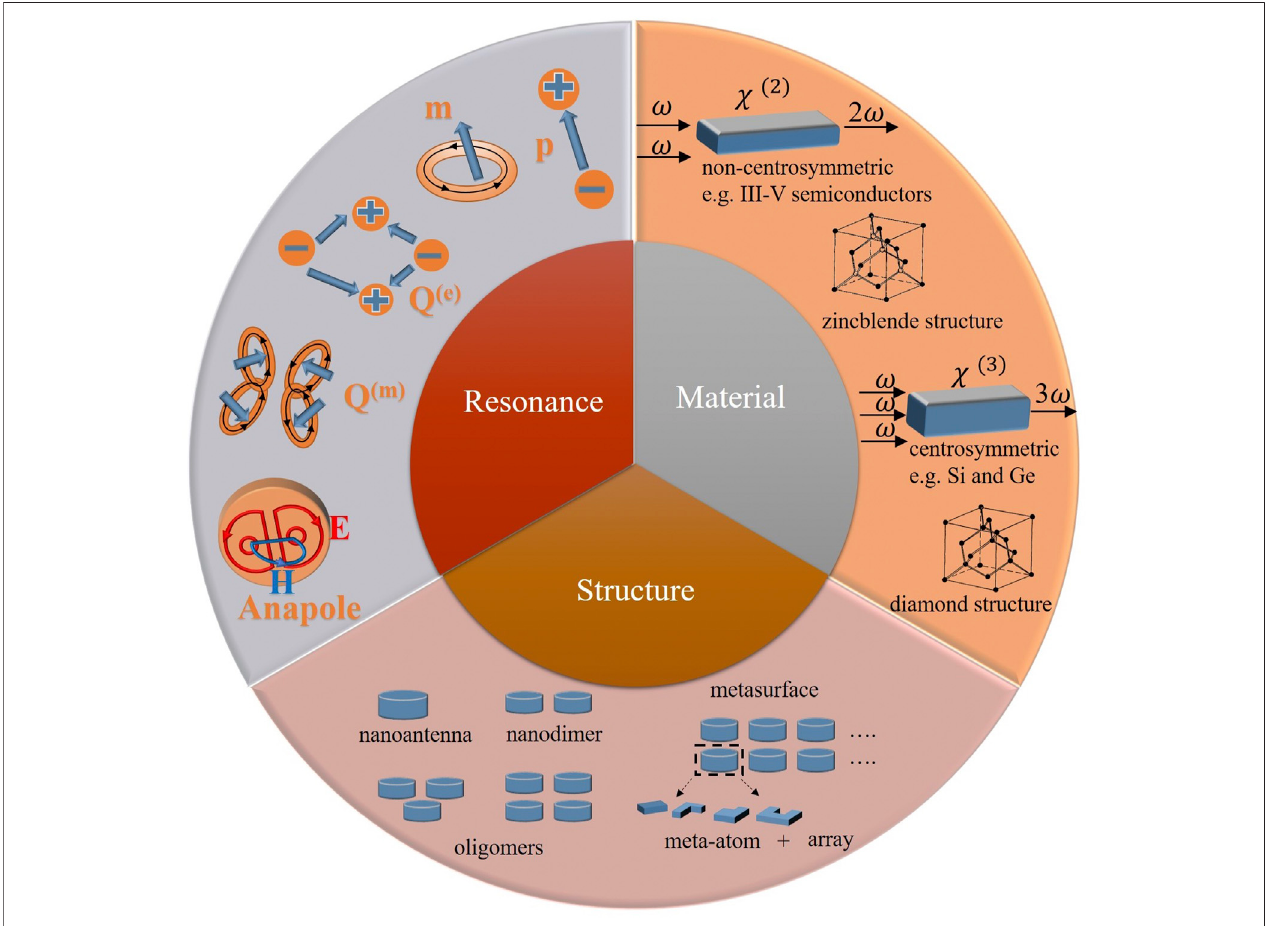
FIGURE 1 | Outline of this review with nonlinear THG and SHG processes from dielectric nanostructures.